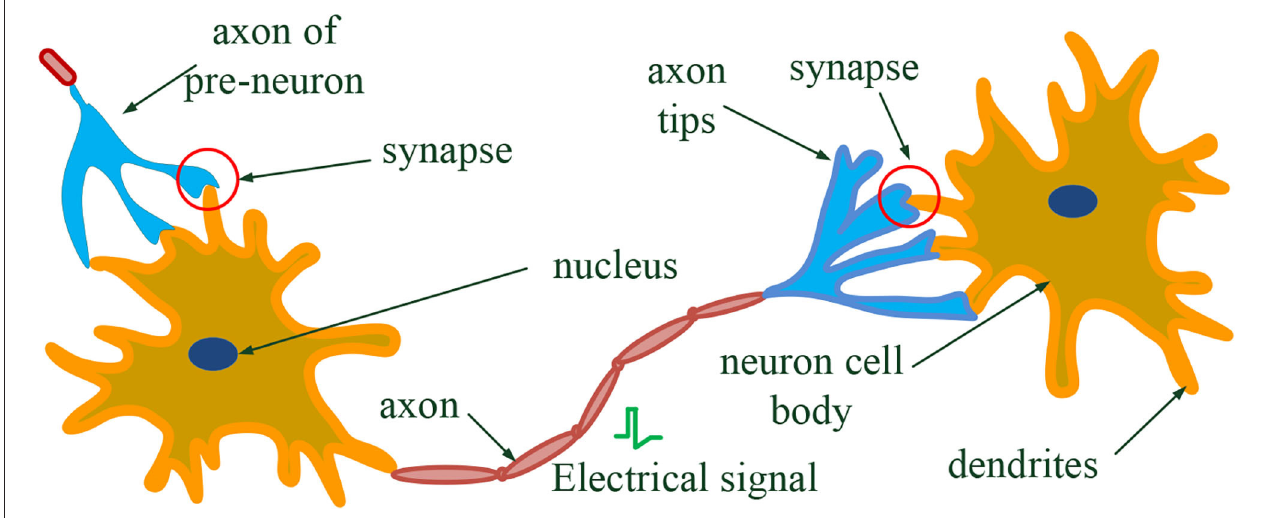
FIGURE 3 | Schematic of two interconnected neurons by